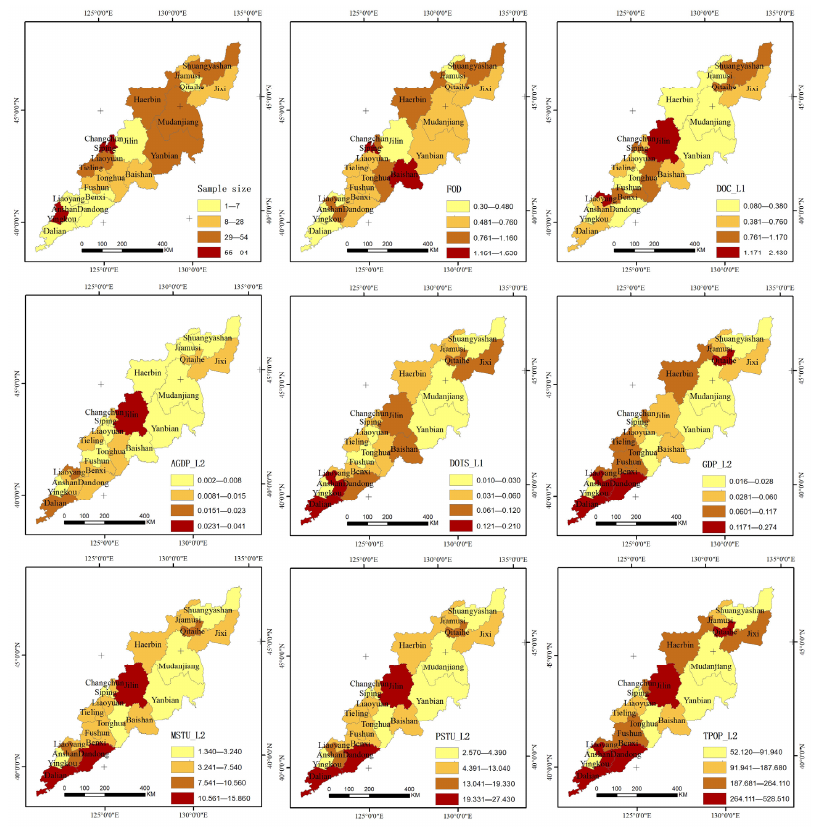
Figure 2. The spatial distribution pattern of the mean values of the fire occurrence density and socioeconomic factors used in multilevel models. A two-level model was designed for county data nested within the upper administrative unit (city) to capture the relationship between fire occurrence density and socioeconomic fac- tors in the two hierarchical levels. The structure of the model is shown in Figure 3.